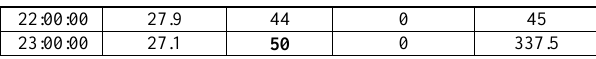
Table 1: Meteorological parameters of simulation day